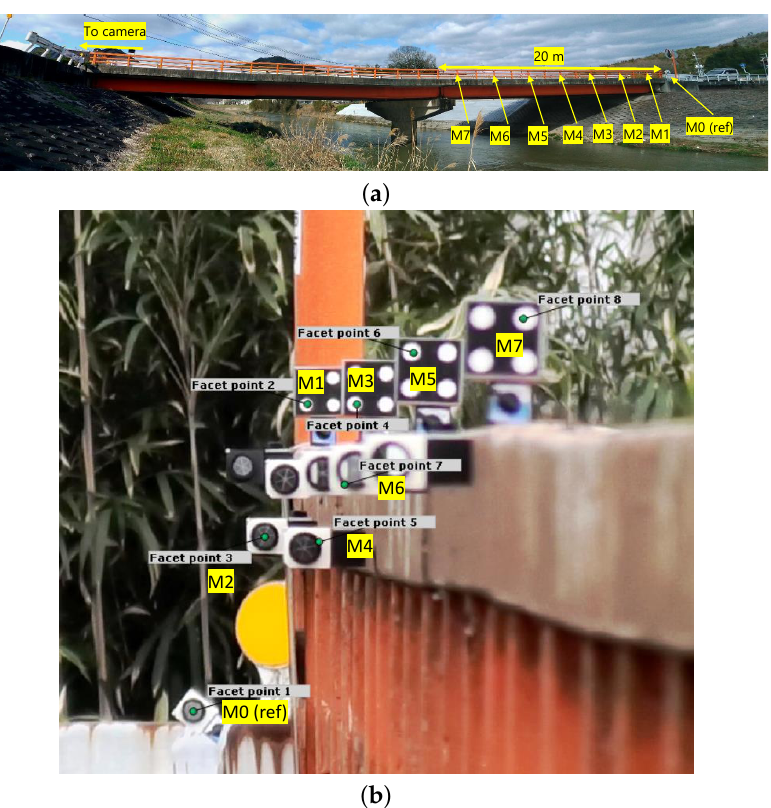
Figure 3. Markers’ placement on the bridge’s outer edge guardrail ( a ) and the cropped field of view from the displacement measurement camera with the markers’ facet assignment for DIC analysis ( b